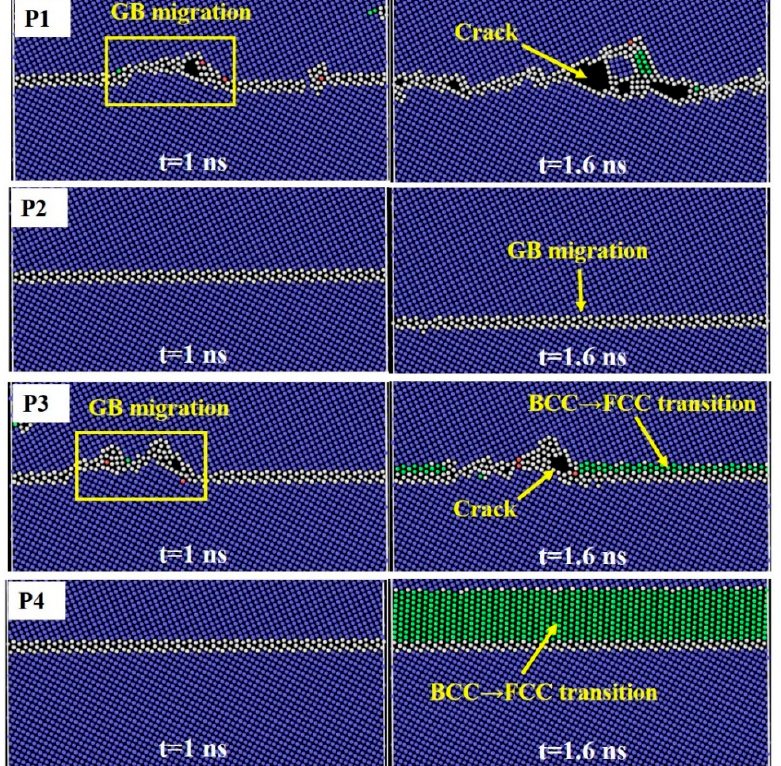
Figure 3. Atomic configuration of Σ 5(310) GB under shear deformation at different simulation times using four interatomic potentials.